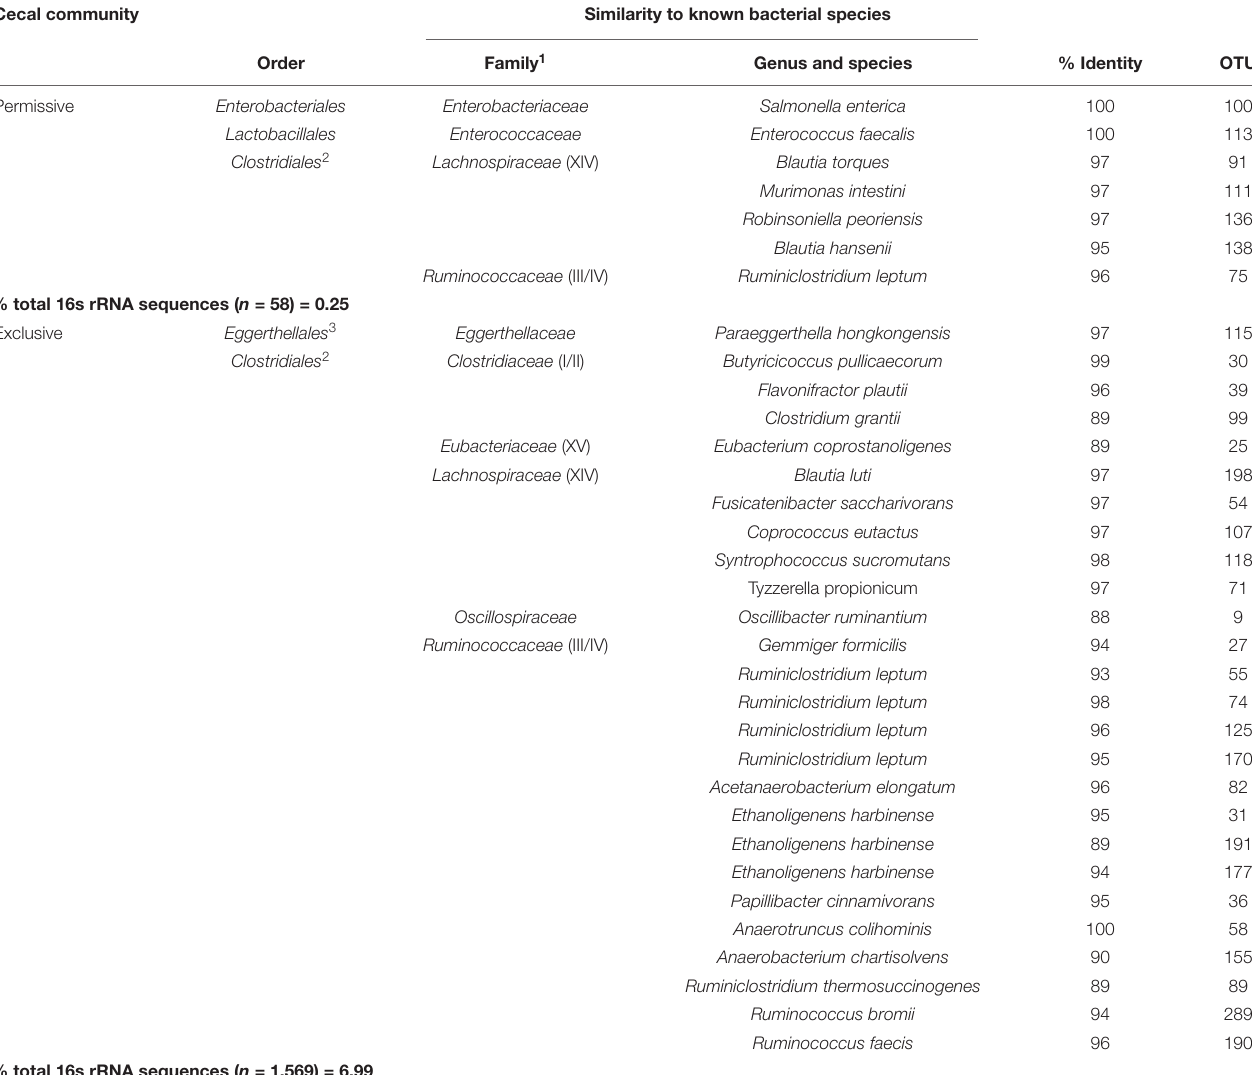
TABLE 3 | OTUs unique to Salmonella exclusive or permissive cecal communities. Cecal